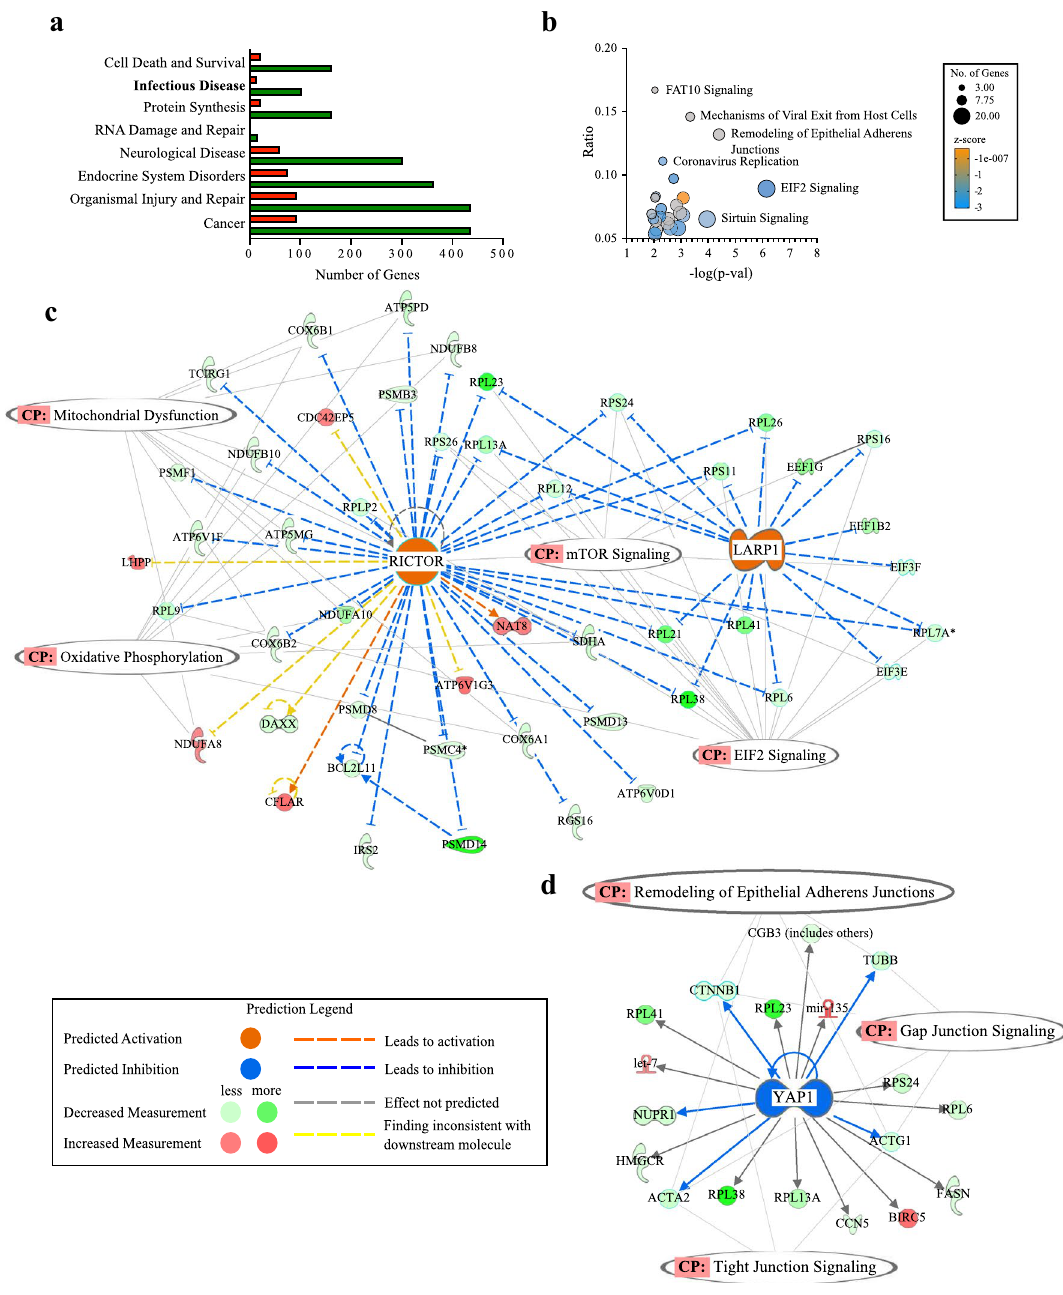
Figure 2. Top disease phenotypes, canonical pathways and predicted upstream regulators of differentially expressed genes in Native Hawaiians when compared to Japanese. ( a ) Number of up- and downregulated genes in most enriched disease phenotypes. Green bars are downregulated genes, red bars are upregulated genes. ( b ) Bubble plot indicating the top canonical pathways, where bubble size corresponds to number of genes enriched for corresponding pathway and color indicates z score. Orange bubbles indicate predicted activation and a positive z score, blue bubbles indicate predicted inhibition and a negative z score. Grey bubbles indicate no z score or a z score of 0. ( c ) Network of genes affected by predicted upstream regulators Lh, LARP1, and RICTOR, and their associated canonical pathways (CP). ( d ) Network of genes affected by YAP1 and associated